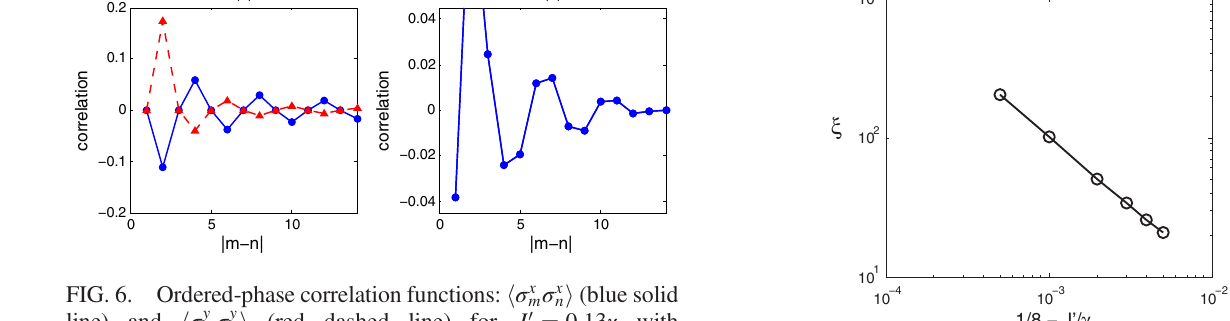
FIG. 6. Ordered-phase correlation functions: h σ x line) and h σ y m σ y n i (red dashed line) for J 0 ¼ 0 . 13 γ with